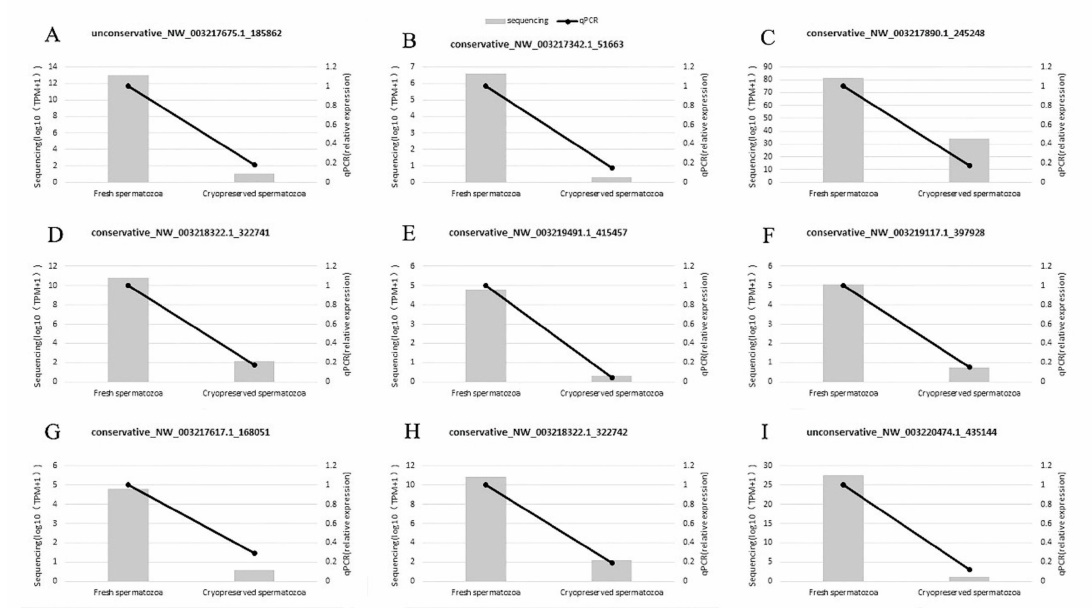
Figure 1. Comparison of RT-qPCR validation and RNA-sequencing results of nine randomly selected miRNAs ( A – I ). The column charts represent sequencing results and the line charts represent RT-qPCR results.